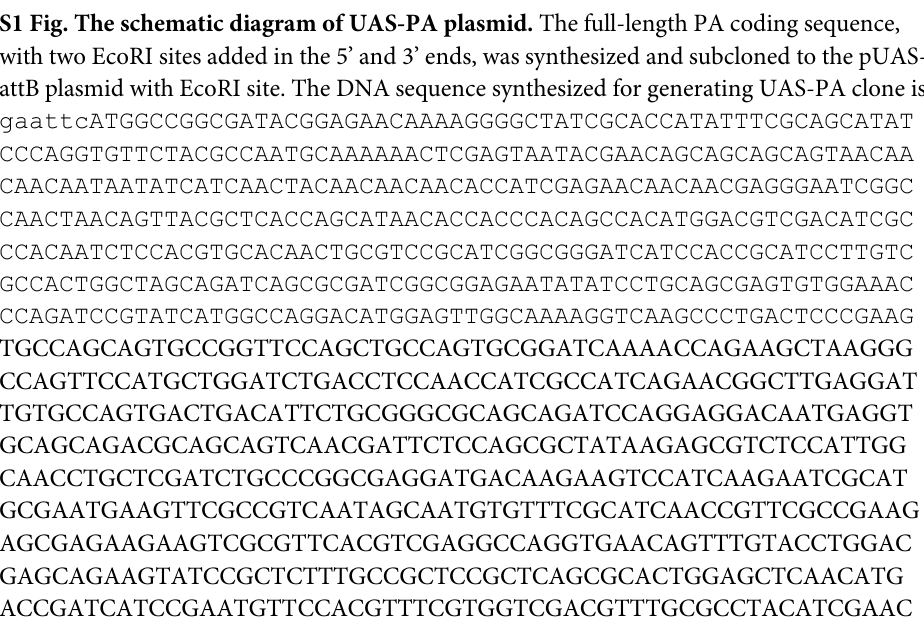
S1 Fig. The schematic diagram of UAS-PA plasmid. The full-length PA coding sequence, with two EcoRI sites added in the 5’ and 3’ ends, was synthesized and subcloned to the pUAS- attB plasmid with EcoRI site. The DNA sequence synthesized for generating UAS-PA clone